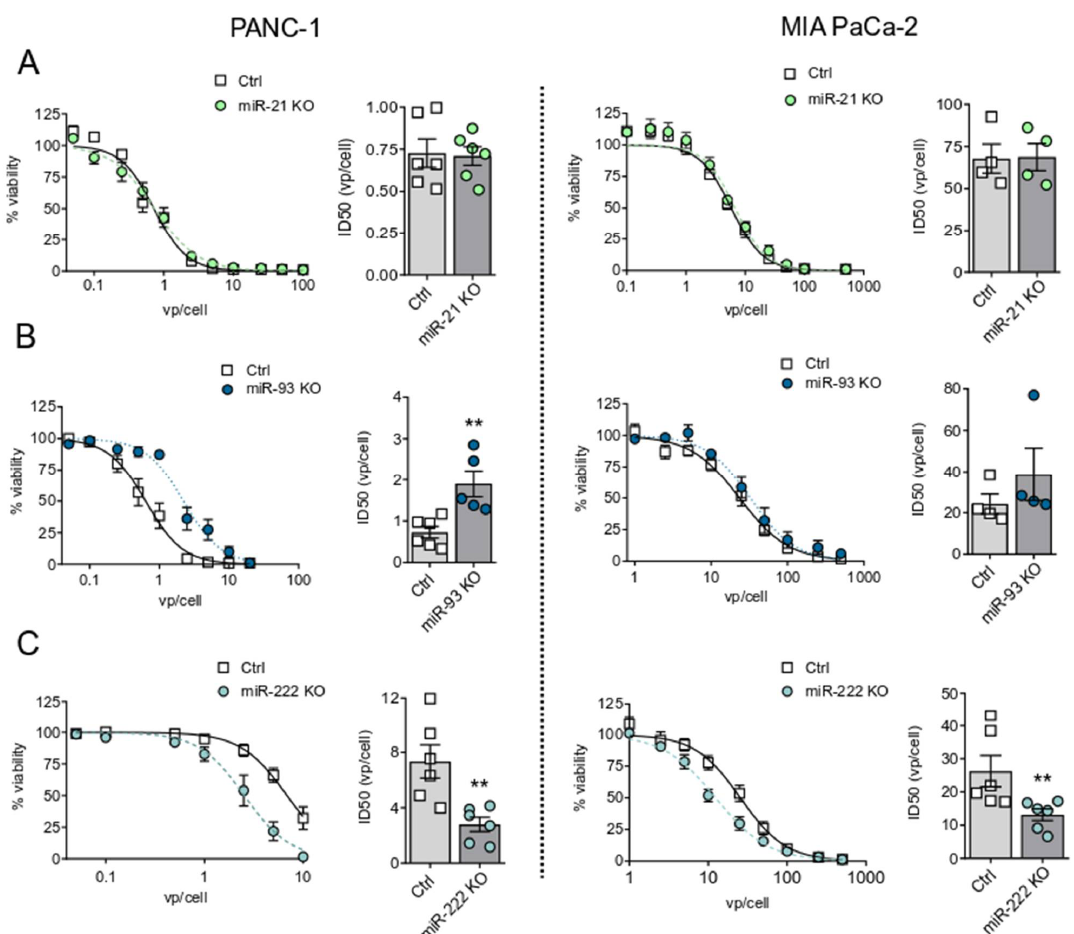
Figure 1. Adenoviral cytotoxicity in miR-21, miR-93, and miR-222 KO PANC-1 and MIA PaCa-2 cell lines. Control and miR-21 KO ( A ), miR-93 KO ( B ), and miR-222 KO ( C ) cells were infected with a dose range of Adwt. Cell viability was measured at 7 days post-infection (PI) by MTT assay, and infectious dose (ID50) values were determined. Data are shown as mean ± SEM for at least 3 independent biological replicates. Significance was assessed using a two-tailed Mann-Whitney test. ** p < 0.01. Cancers 2021 , 13 , 3233